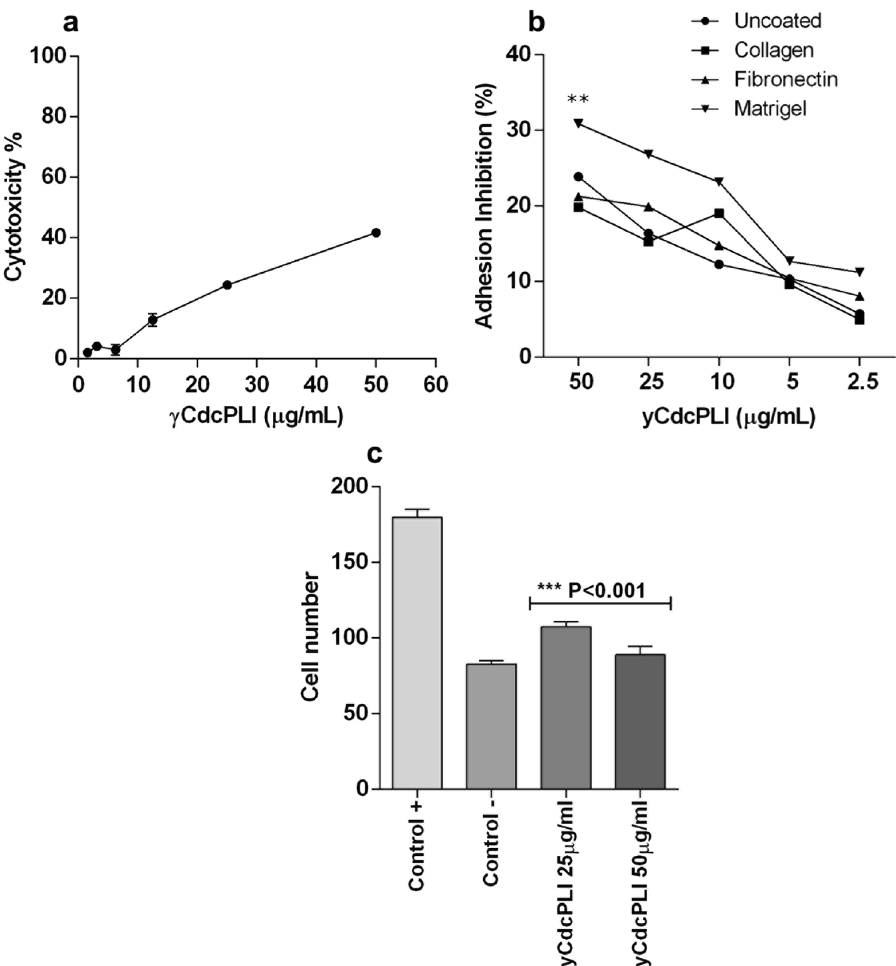
Figure 4. Cytotoxicity induced by γ CdcPLI in HUVEC cells and effect of γ CdcPLI inhibitor on adhesion and migration of HUVECs cells. ( a ) Cytotoxicity percentage of HUVECs treated with γ CdcPLI (50, 25, 12.5, 6.25, 3.125, 1.560 µ g/mL) for 24 h. ( b ) Adhesion cell inhibition by γ CdcPLI at different concentrations (50, 25, 10,